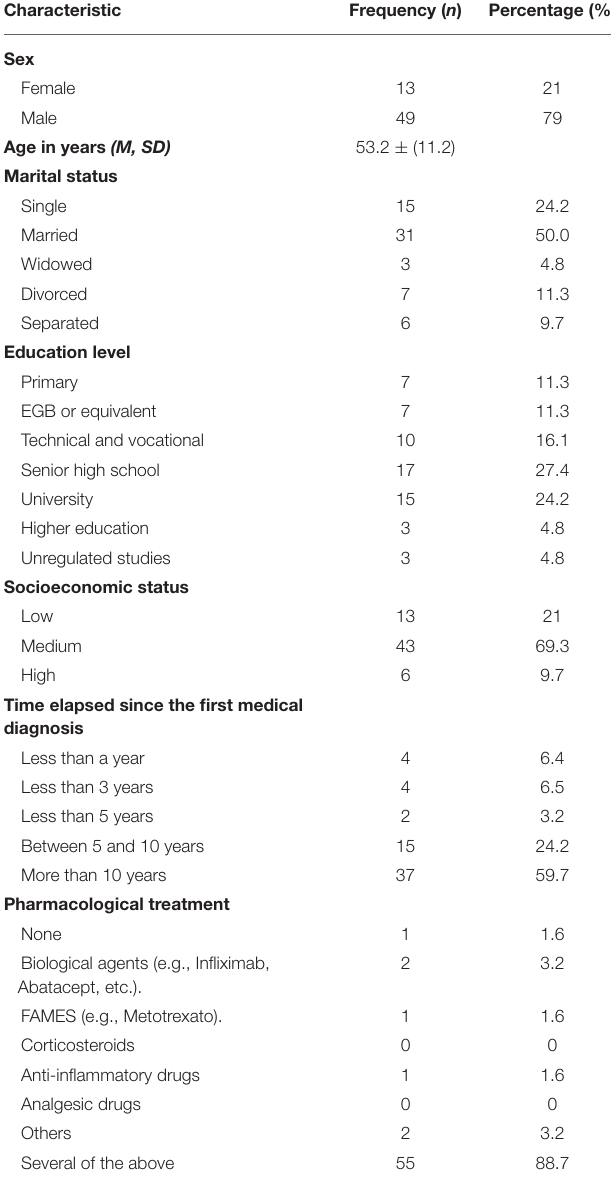
TABLE 1 | Sociodemographic characteristics and clinical variables of the study